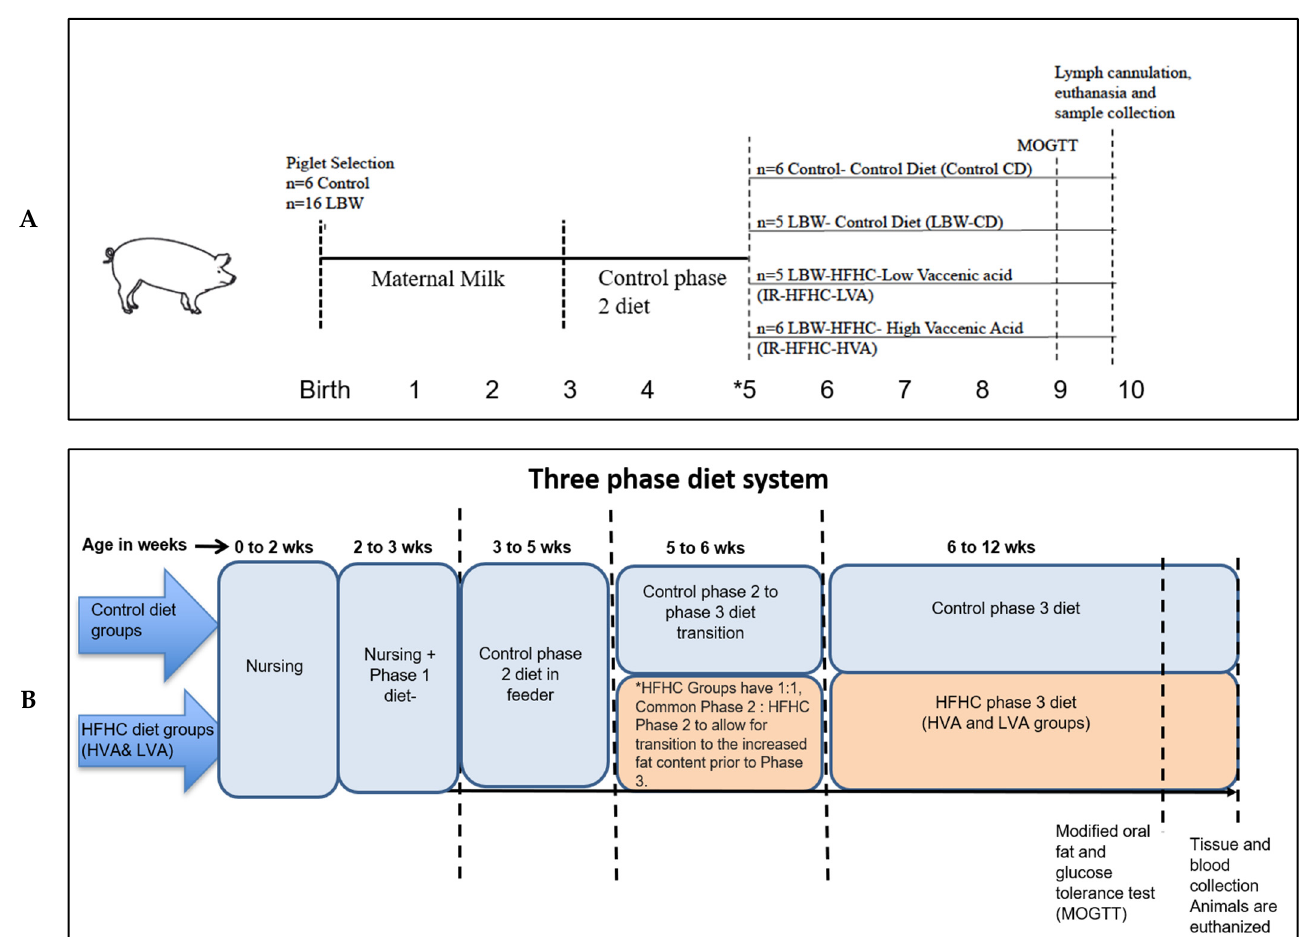
Figure 1. ( A ) Study design schematic: Normal and LBW pigs were fed control, HFHC diet, or HFHC diet supplemented with VA for 5 weeks post-weaning. IR Insulin resistant; MOGTT, modified oral glucose tolerance test; HFHC, high-fat, high-carbohydrate; VA, vaccenic acid. * For HFHC groups, HFHC phase 2 diet (HVA and LVA) partially started at 5 weeks (mixed 1:1 with control Phase 2 diet), completely switched to HFHC phase 3 diets at 6 weeks. ( B ) Three phase diet system: At 2 to 3 weeks of age, pigs are given crumbled solid feed, like giving baby pablum introduced by creep feeder. At 3 to 5 weeks of age all pigs are fed a control phase 2 diet. From 5 to 6 weeks denotes the transition period as described earlier. At week 6 all groups are on respective phase 3 diets. All diets were appropriate for the respective growth stage of the pigs.